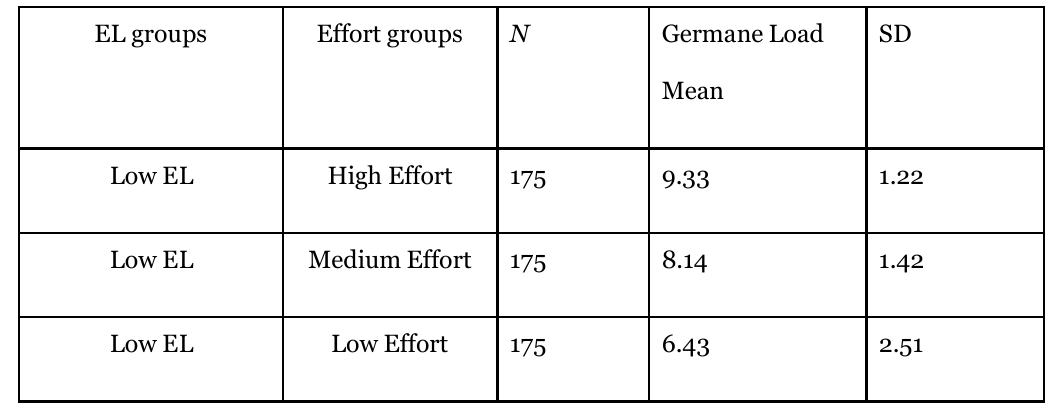
Mean Germane Load by Extraneous Load and Effort